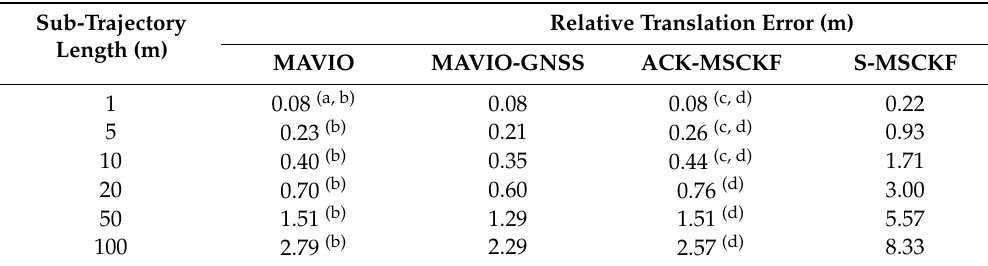
Table 6. The overall relative translation error (RTE) for all of the experimental